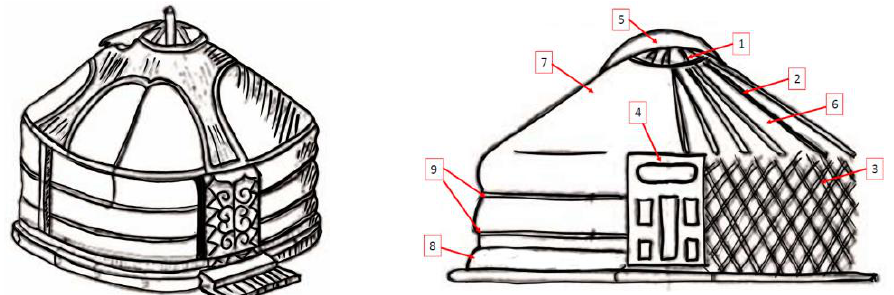
Figure 1. Traditional elements of Mongolian Yurt. Wooden frame: 1. Toono-crown, 2. Uni-poles, 3. Walls, 4. Door. Felt cover: 5. Urkh, 6. Inside the felt roof, 7. Outside felt roof, 8. Khayaavch-felt or wooden boards closing off the lower edge of a yurt wall in winter, 9. Outside belt.